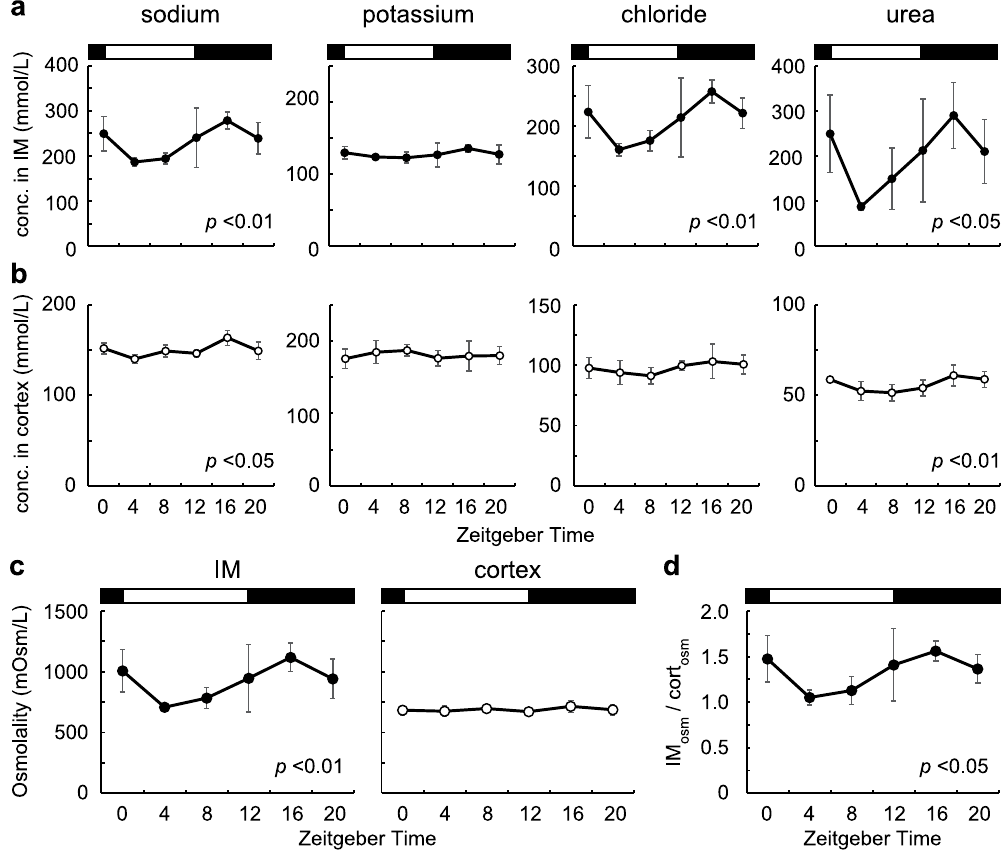
Figure 2. Diurnal variations of electrolytes, urea concentrations, and osmotic pressure in rat kidney. (a–b) Diurnal variations of electrolytes and urea concentrations in the IM ( a ) and cortex ( b ). From left to right, diurnal variations of sodium, potassium, chloride, and urea concentrations are shown. ( c ) Osmotic pressure in the IM (left) and cortex of the rat kidney (right). ( d ) IM-cortex osmotic pressure ratio (IM osm /cort osm ) representing osmotic pressure gradient. Mean values ± standard deviations (S.D.) (n = 4). White and black rectangles in graphs indicate the light phase and the dark phase,